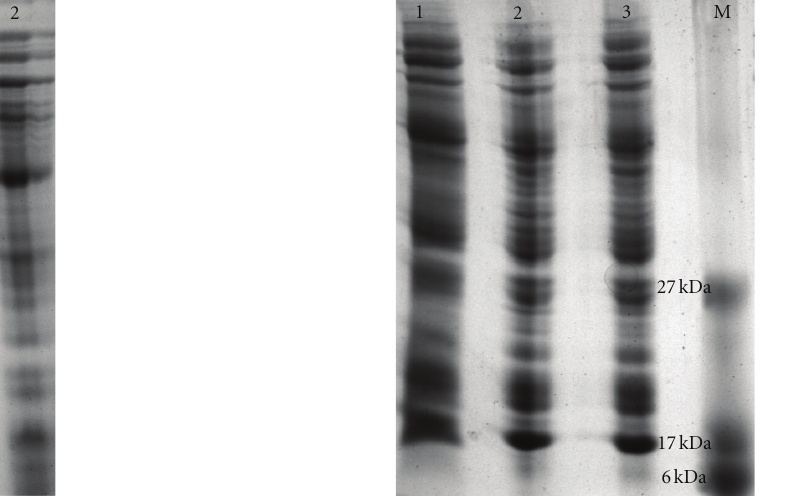
Figure 3: Total protein profile of recombinant E. coli DH5 α showing in vivo translation. Lane 1: total protein profile of E. coli DH5 α -pGEM, Lane 2: total protein profile of E. coli DH5 α - pGEpmt, Lane 3: total protein profile of E. coli DH5 α -pGEpmt after IPTG